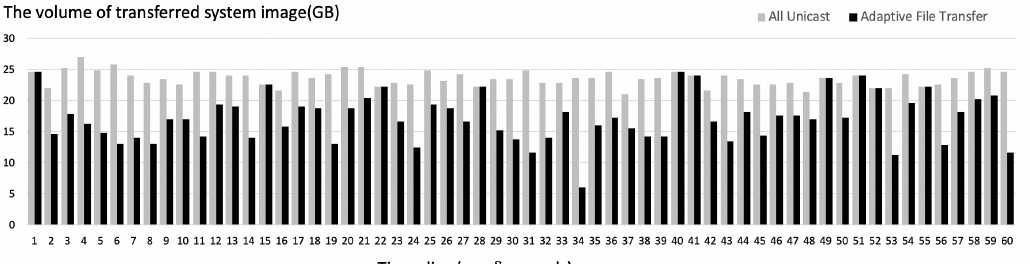
Figure 14. System image requests per time slice ( δ seconds) simulated on the